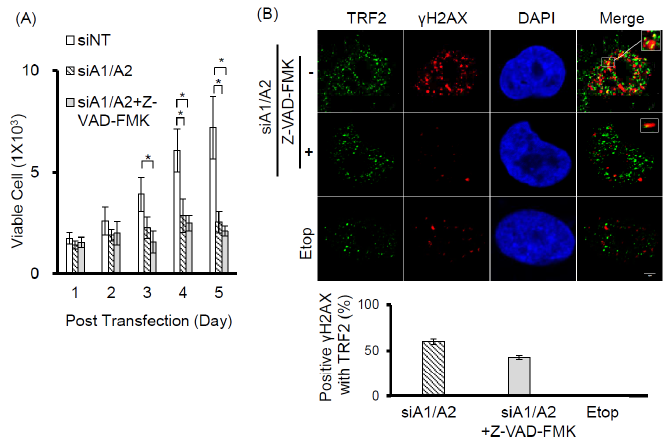
Figure 4. Effects of early apoptosis inhibition on DDR and cell proliferation. ( A ) A549 cells were transfected with siRNA targeting sequences for both hnRNP A1 and A2 (siA1/A2) in the presence or